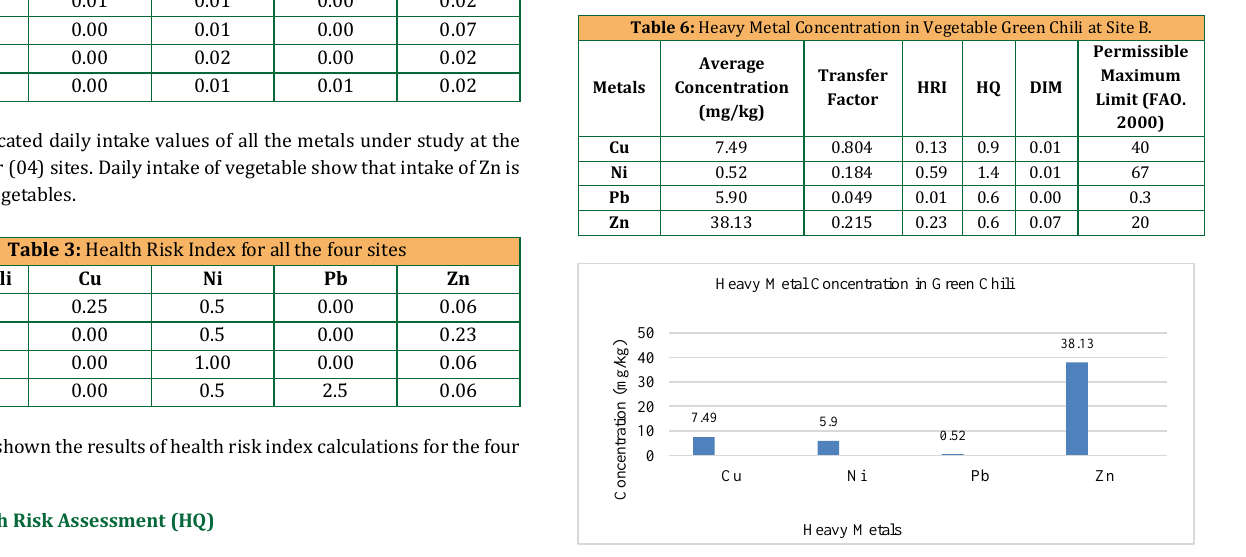
Figure 3: Average concentration in green chili site